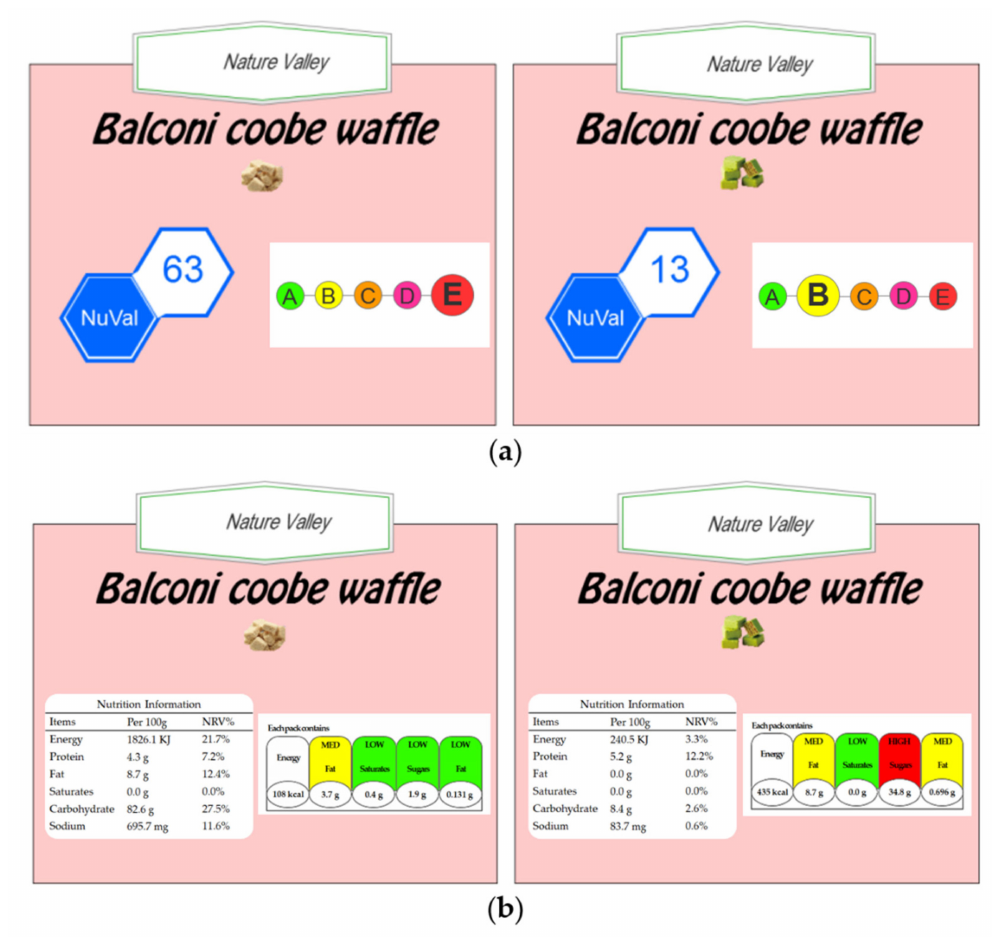
Figure 5. Examples of food images presented in Experiment 2: ( a ) illustrates a pair of waffles accompanied by both NuVal labels and 5-CNL labels; ( b ) illustrates the paired foods with both traffic light labels and DV